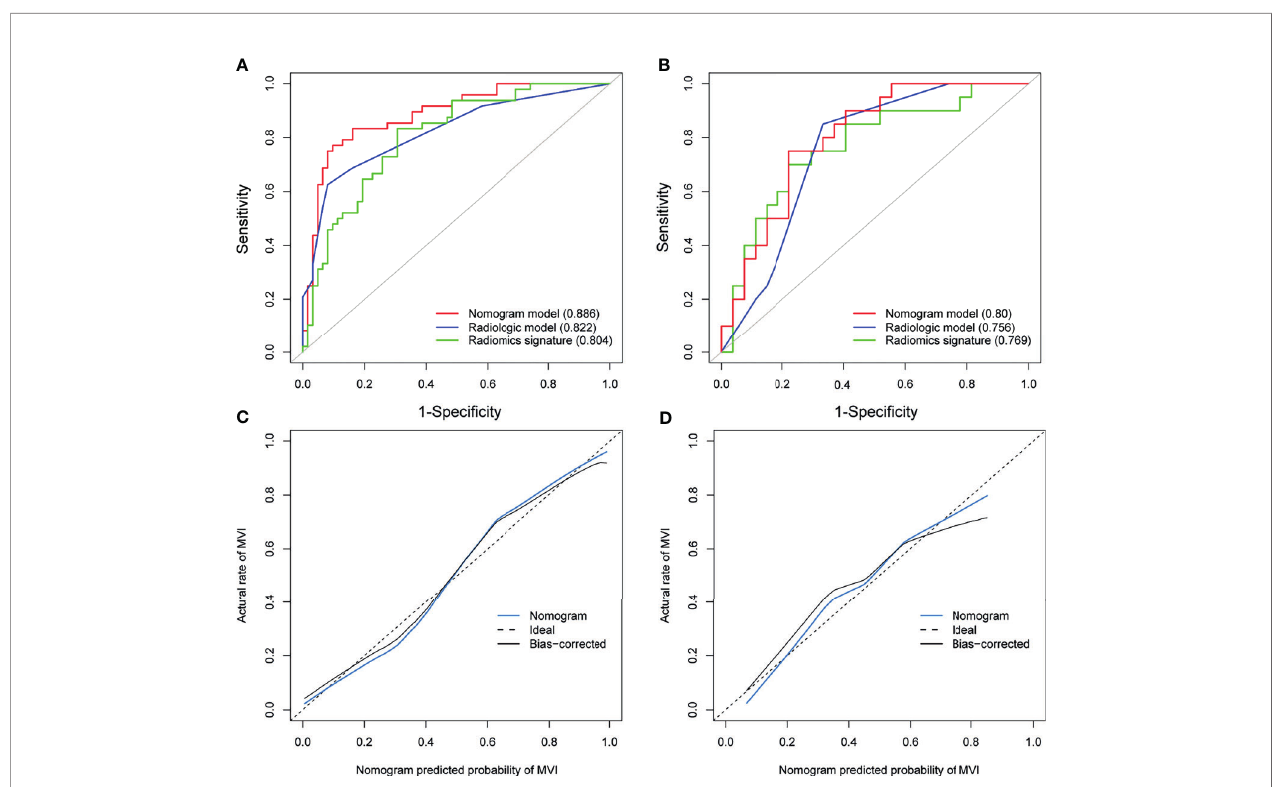
FIGURE 5 | Assessing the discriminative performance of the nomogram and comparison with other predictive models. The nomogram showed a signi fi cantly higher discriminative power than the radiomics signature and the radiologic model for the prediction of microvascular invasion in the training dataset (A) , but did not differ in the test dataset (B) . The calibration plots demonstrate that the nomogram-predicted probabilities were consistent with actual MVI incidence in the training (C) and test (D) datasets.